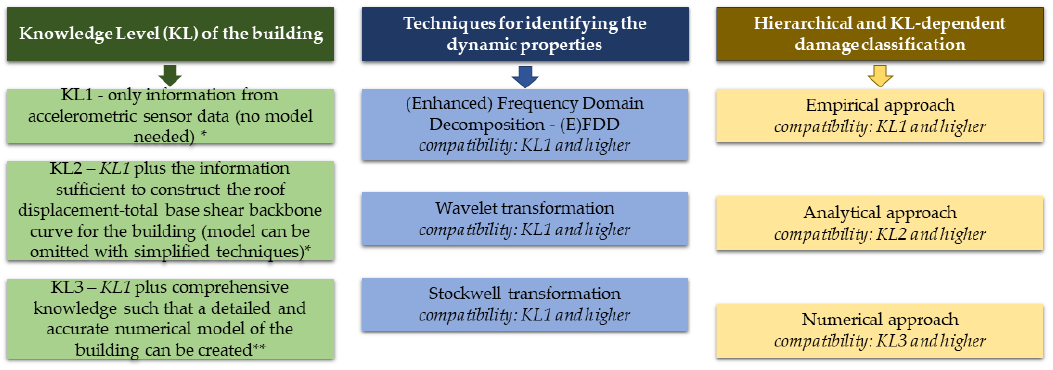
Figure 1. Definitions of knowledge levels, dynamic identification techniques, and KL-dependent damage classification methods.